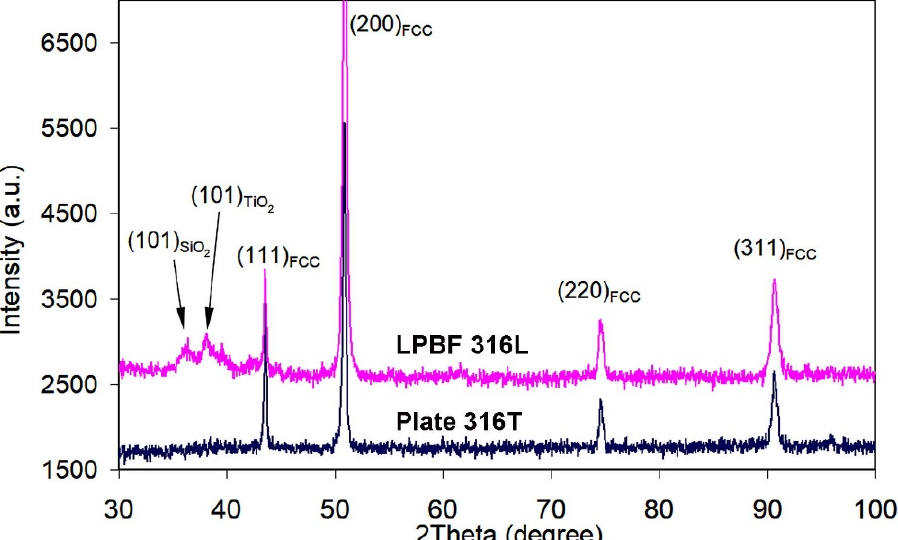
Figure 9. XRD patterns of pulsed-plasma-treated specimens.